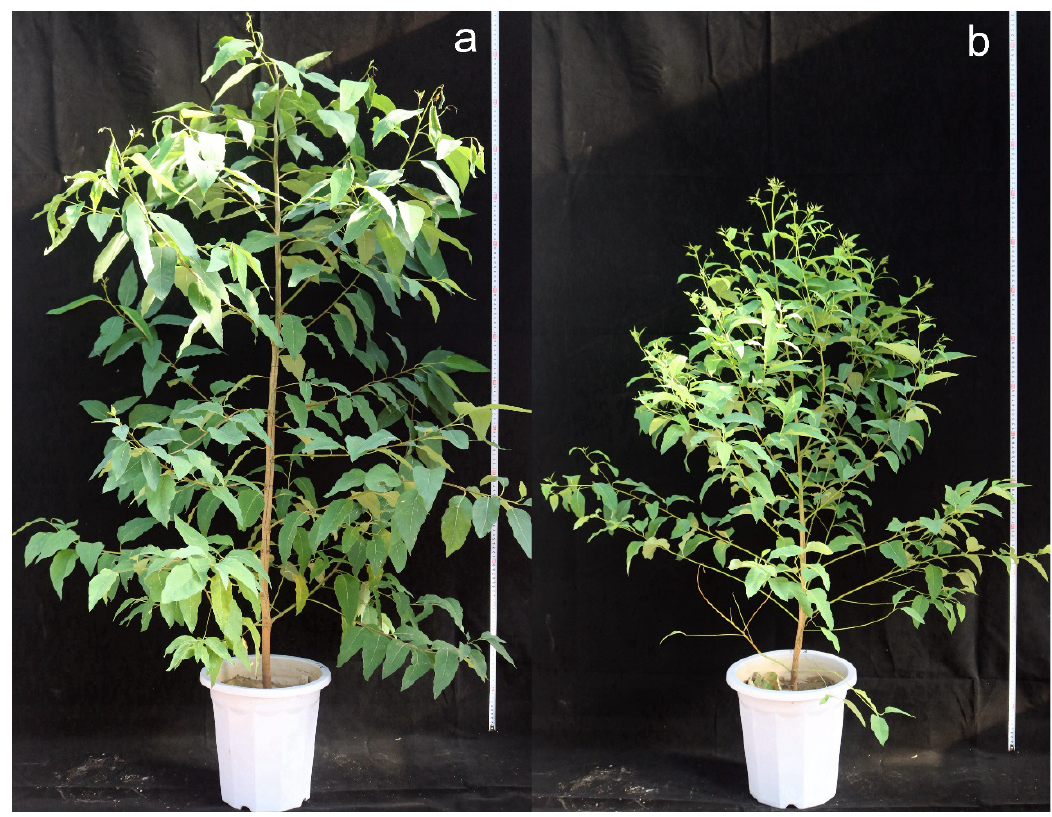
Figure 4. Eucalypts grown in greenhouse at 6 months old. ( a ) Triploid plant. ( b ) Diploid plant.